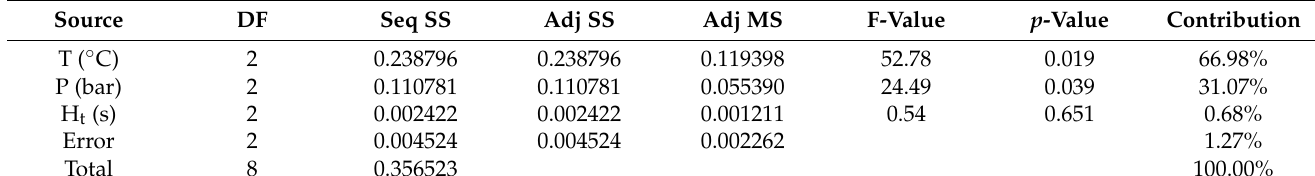
Table 7. ANOVA table for GRG.